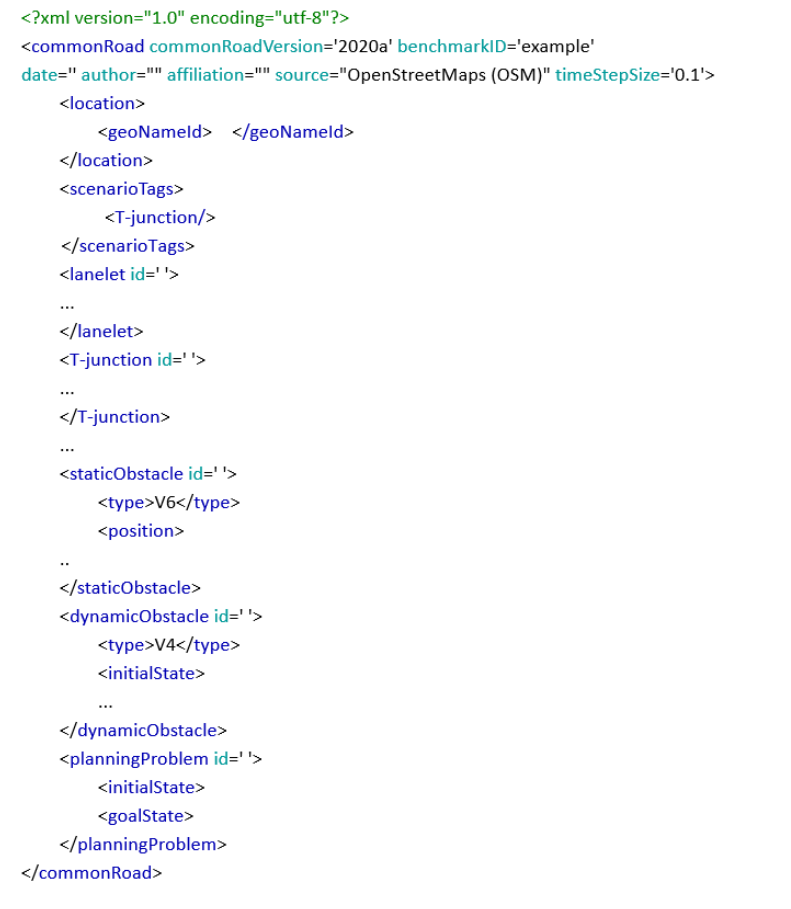
Figure 10. CommonRoad Scenario